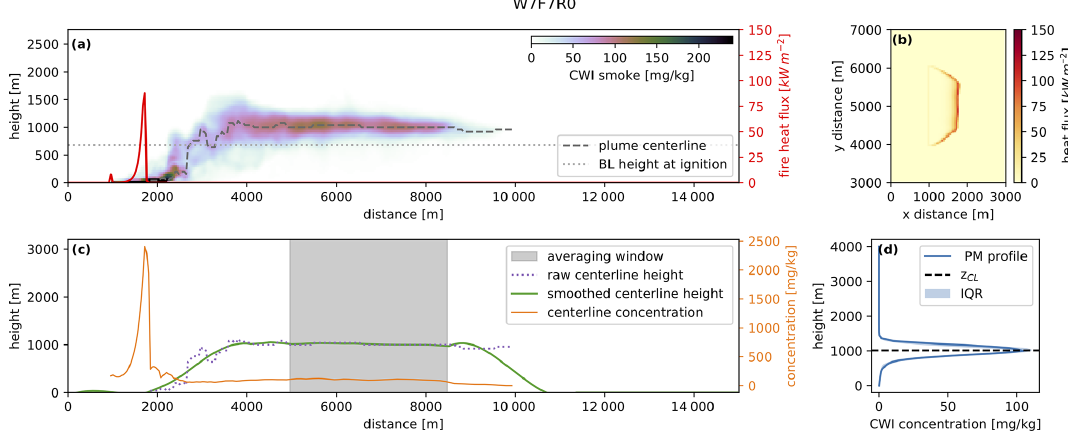
Figure 2. Illustration of the approach to identifying a quasi-stationary downwind region in CWI smoke distribution using a sample LES experiment. (a) CWI smoke concentrations. Also shown are plume centerline height (dashed), z i (dotted) and CWI fireline intensity (solid red, secondary axis). (b) Plan view of fire heat flux showing the fireline. (c) Quasi-stationary region (grey shading). Also shown are raw (dotted purple) and smoothed (solid green) centerline heights and the tracer concentration gradient (solid orange, secondary axis). (d) Representative downwind smoke distribution. The profile (solid blue line) is obtained by horizontally averaging the CWI smoke concentrations in the quasi-stationary region (dashed grey in c ). Also shown are the IQR (interquartile range, light blue shading) and the derived smoke injection centerline height z CL (dashed